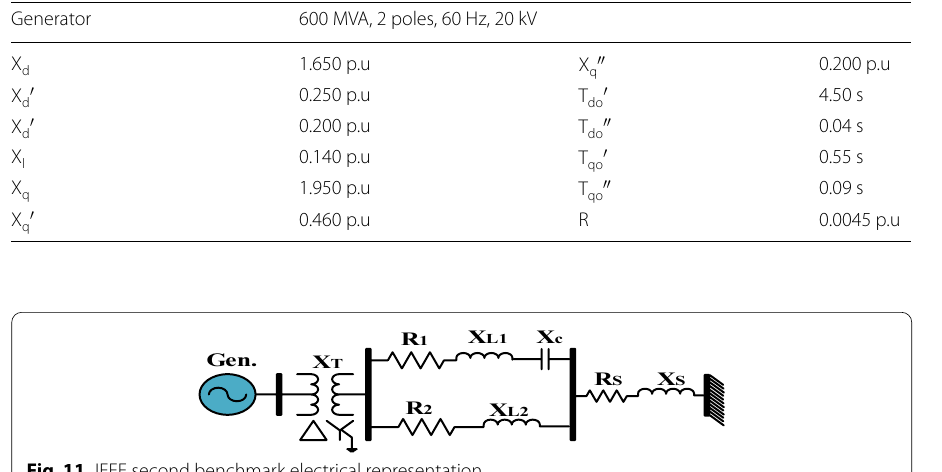
Table 2 Machine electrical parameters